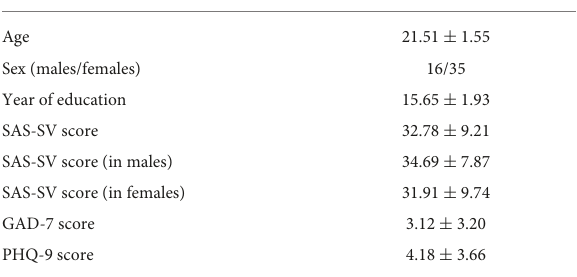
TABLE 1 Characteristics of the final analyzed sample ( n =